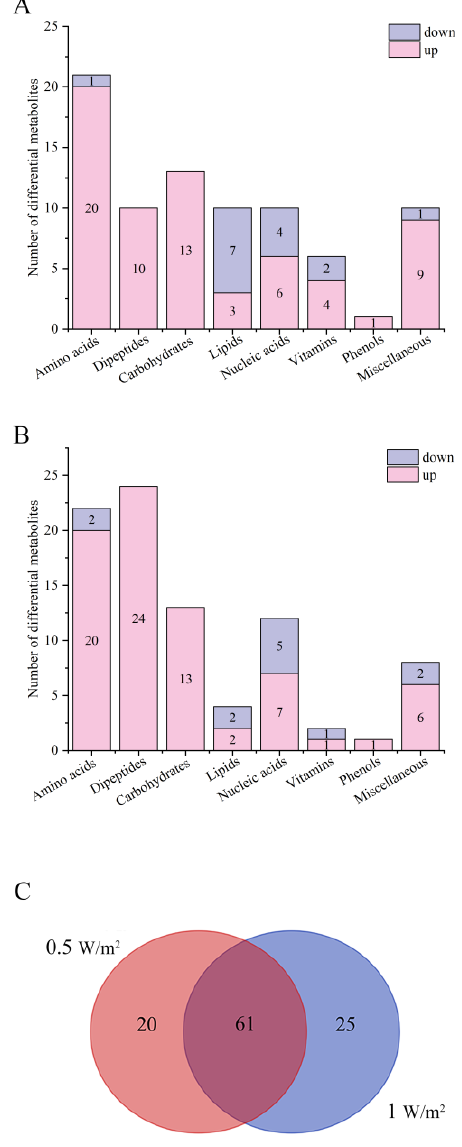
Figure 3. Metabolite analysis of Porphyra haitanensis under different UV-B radiation intensities. ( A ) Differential metabolites in the 0.5W/m 2 UV-B treatment compared with the control; ( B ) differential metabolites in the 1W/m 2 UV-B treatment compared with the control; and ( C ) Venn diagram of differential metabolites under different UV-B radiation intensities.